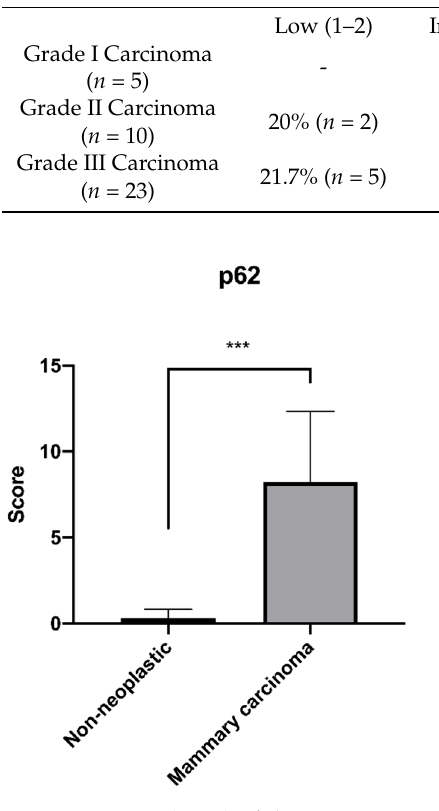
Figure 2. Mean ( ± SD) of the immunoreactivity score for p62 in the 38 cases of feline mammary Figure 2. Mean (±SD) of the immunoreactivity score for p62 in the 38 cases of feline mammary carcinoma and 12 non-neoplastic tissue (*** p < 0.001). carcinoma and 12 non-neoplastic tissue (*** p < 0.001).